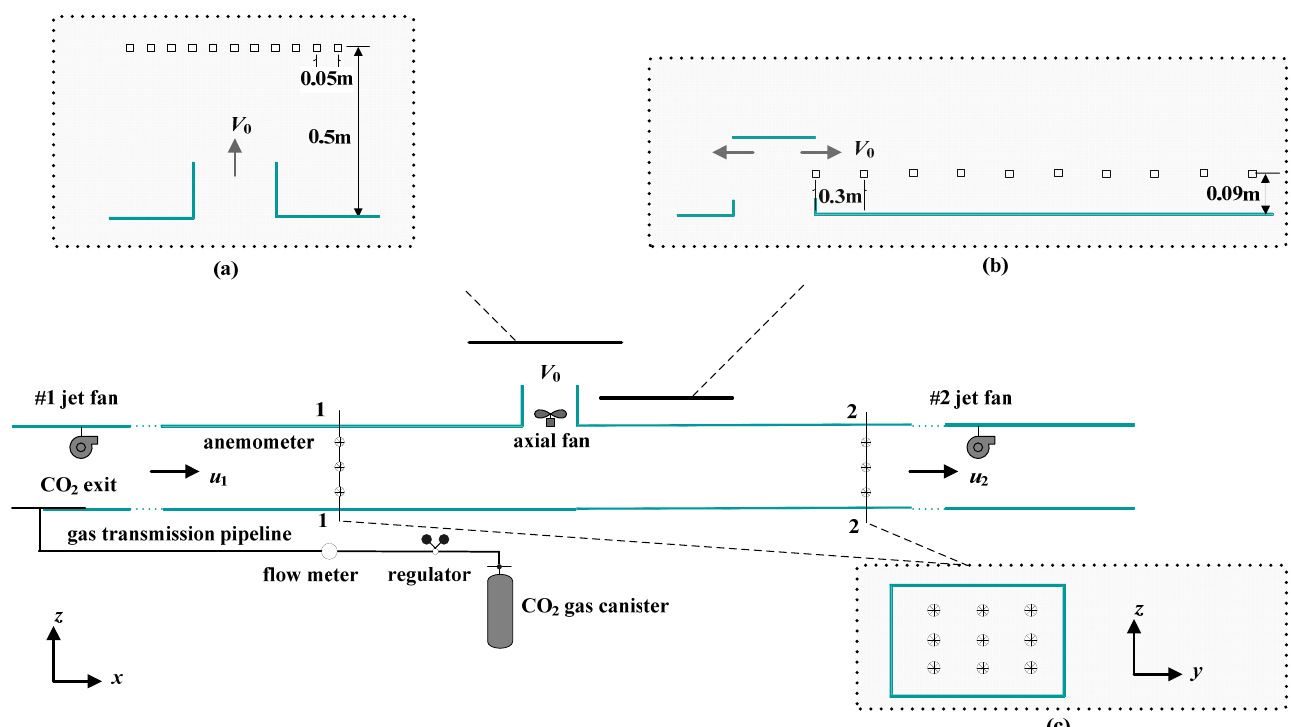
Figure 6. Diagram of wind speed and concentration measurement points: ( a ) a series of CO 2 concentration sampling points for the vertical outlet; ( b ) a series of CO 2 concentration sampling points for the horizontal outlet; ( c ) wind speed measuring points for cross sections 1-1 and 2-2.